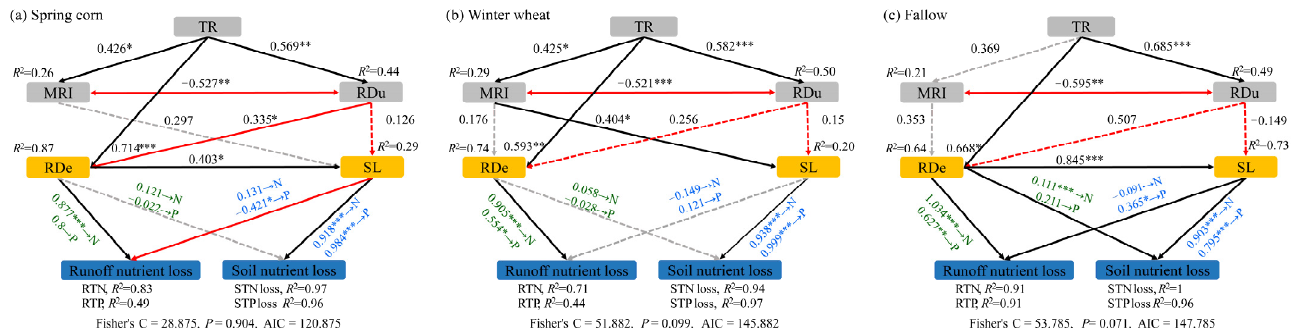
Figure 7. Structural equation models show the pathways and coefficients affecting runoff, soil erosion, and nutrient loss. Insignificant paths ( p ≥ 0.05) are semi-transparent dashed lines, while significant paths ( p < 0.05) are shown with solid lines. Black and red arrows indicate positive and negative pathways, respectively. Conditional R 2 denotes the proportion of variance explained. The standardized path coefficient represents the extent of the effect of the independent variable on the dependent variable. Significant pathways are marked by: *, p < 0.05; **, p < 0.01; ***, p < 0.001.